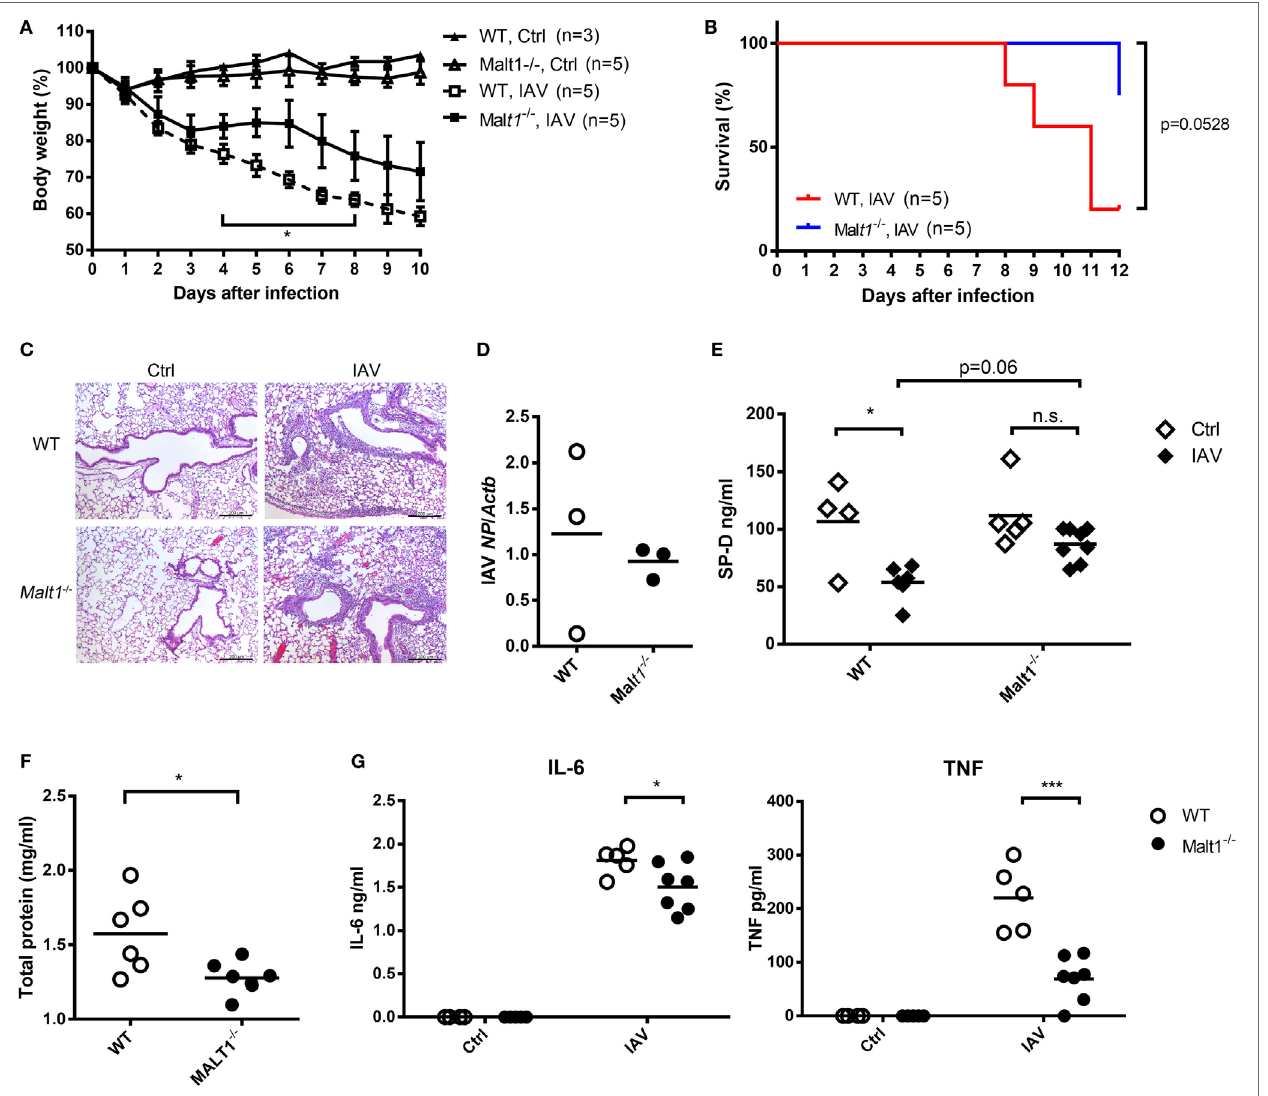
FigUre 7 | Malt1 − / − mice sustain less disease severity after IAV infection. (a,B) Wild-type (WT) and Malt1 − / − mice were infected with or without 1.5 × 10 4 PFU of HKx31 of IAV intratracheally [ n as indicated in panels (a,B) ]. Body weight and survival were recorded daily. (c–g) Wild-type and Malt1 − / − mice were infected with or without 5 × 10 3 PFU of WSN virus. (c) Lungs were collected on day 4 after infection and fixed by formaldehyde and stained with hematoxylin and eosin stain (uninfected WT and Malt1 − / − Ctrl, n = 2 each; WSN-infected WT and Malt1 − / − mice, n = 3 each. One representative experiment is shown). (D) Total RNA of lungs was extracted on day 4 after infection and nucleoprotein of IAV mRNA was quantified by qPCR and normalized against Actb . (e–g) Bronchoalveolar lavage was collected from mice on day 4 after infection. The concentrations of (e) surfactant protein D (SP-D) and (g) IL-6 and TNF were quantified by ELISA. (F) Total protein was determined by Bradford protein assay. (D–g) Each dot represents sample from one mouse. n.s., not significant, * p < 0.05, and *** p < 0.001 compared to control. (a) Comparisons between IAV-infected WT and Malt1 − / − at the same time point and data in (D,F) were analyzed by Mann–Whitney U -test. Data in (B) were analyzed by log-rank (Mantel–Cox) test. Data in (e,g) were by one-way ANOVA followed by (e) Tukey’s and (g) Sidak’s post hoc